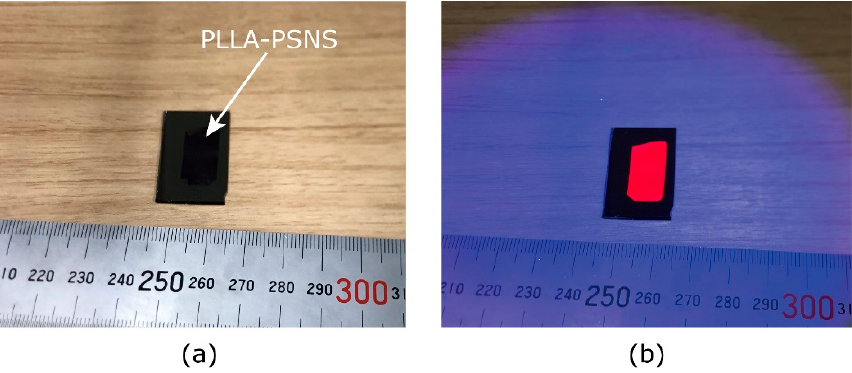
Figure 2. Typical example of PLLA-PSNS transferred on silicon wafer. ( a ) PLLA-PSNS image with- out illumination. ( b ) PLLA-PSNS image with illumination.